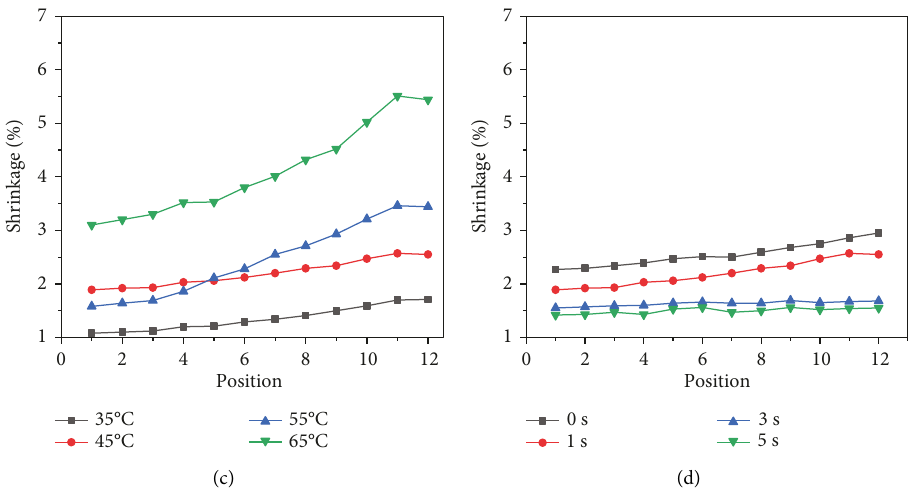
Figure 6: Effects of process parameters on shrinkage of WAIM 20% SGFRPP products, (a) water injection pressure, (b) melt temperature, (c) mold temperature, and (d) water injection delay